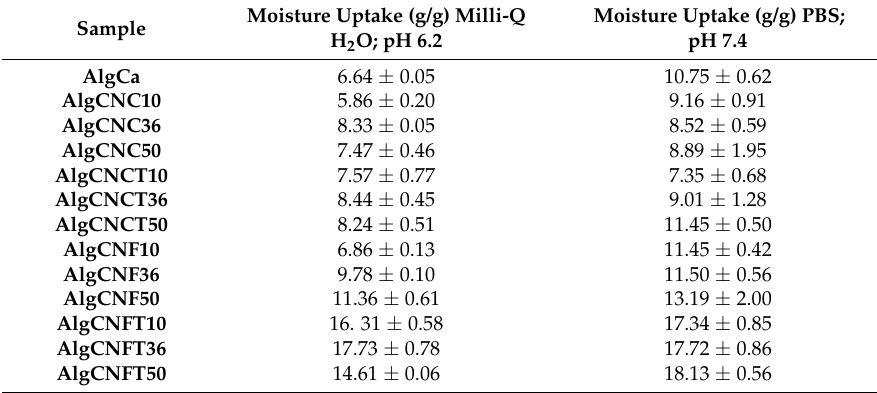
Table 2. Maximum moisture uptake after swelling tests during 2 h at 37 ◦ C in milli-Q water pH 6.2 and in PBS pH 7.4 for the pure alginate gels and alginate-nanocellulose